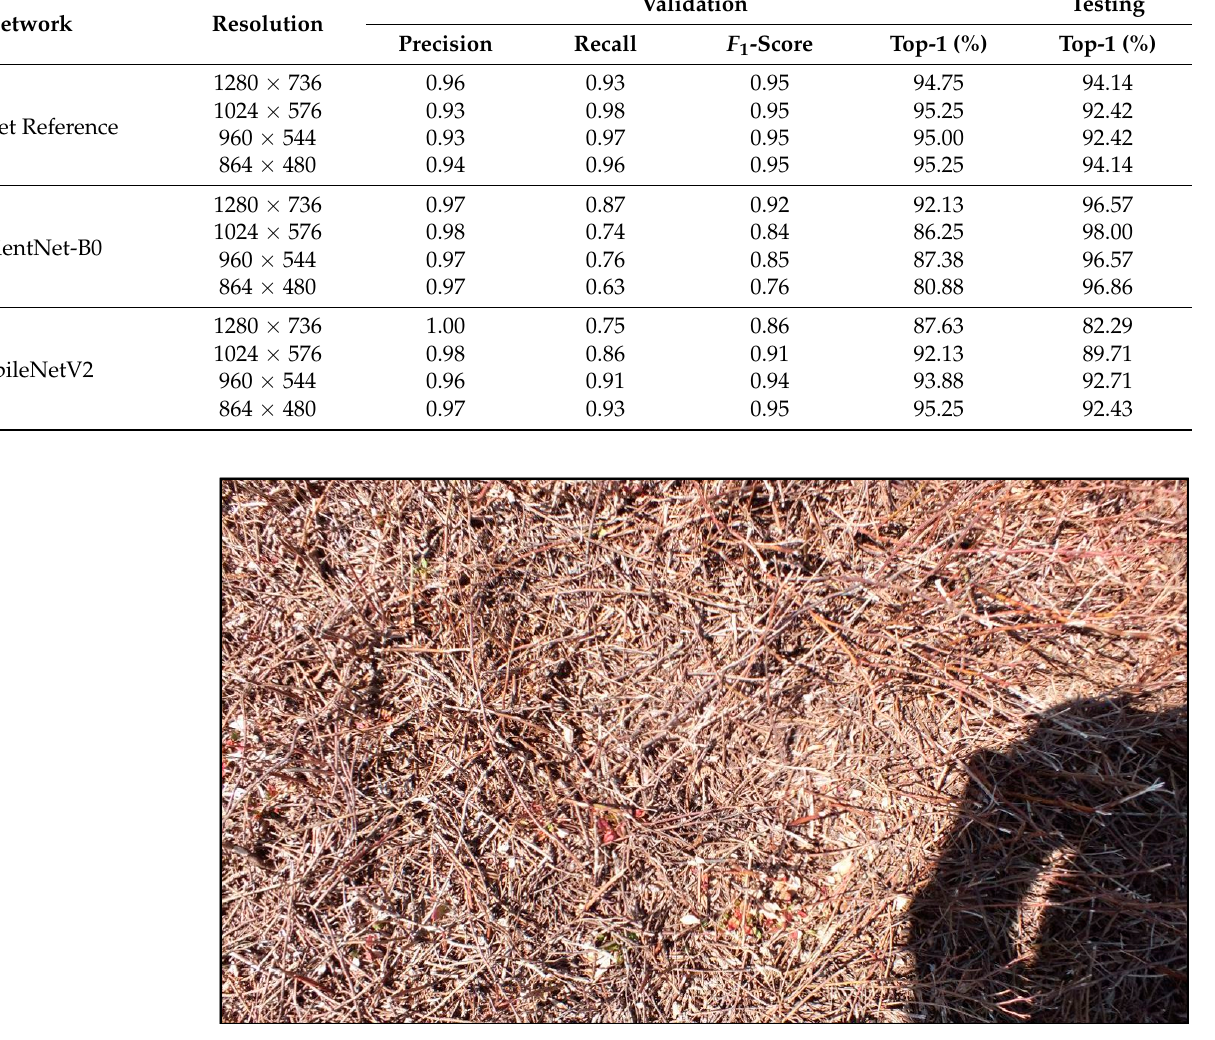
Figure 6. An image from spring 2019 with sheep sorrel that was misclassified as “not sheep sorrel” by Darknet Reference at 1280 × 736 resolution. Many of the sheep sorrel leaves in this image contain red hues, resulting in less contrast from the wild blueberry branches than the sheep sorrel leaves in Figure 3.